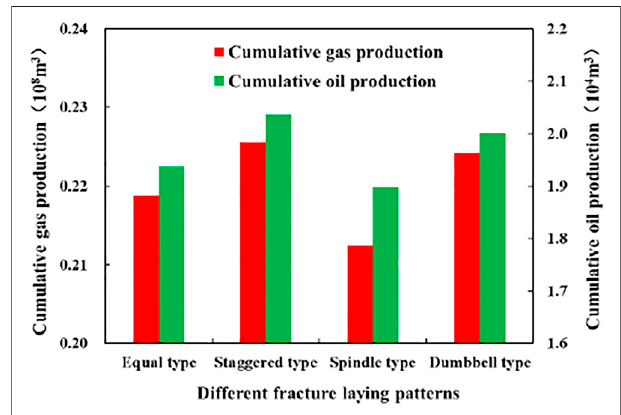
FIGURE 12 | Cumulative condensate and gas production of different fracture laying patterns.